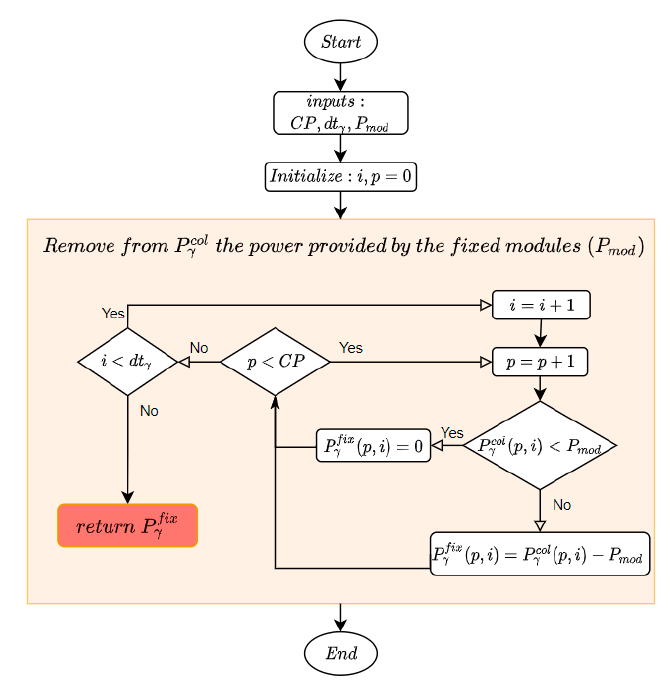
Figure 7. Flowchart to compute the power provided by the fixed modules.